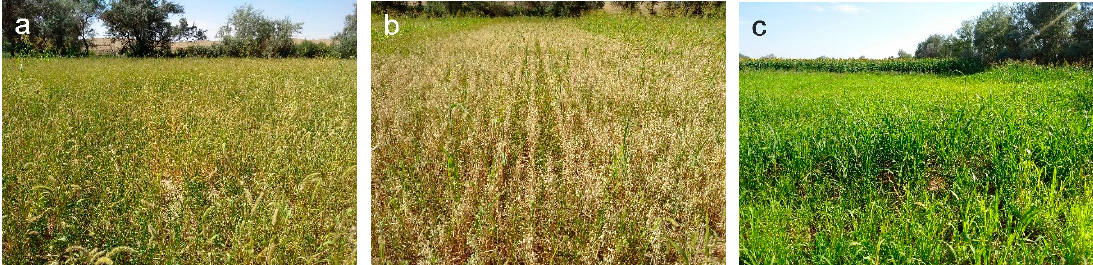
Figure A4. Representative pictures of alfalfa monocrop ( a ), alfalfa / oat intercrops ( b ) and alfalfa/sudangrass intercrops ( c ).